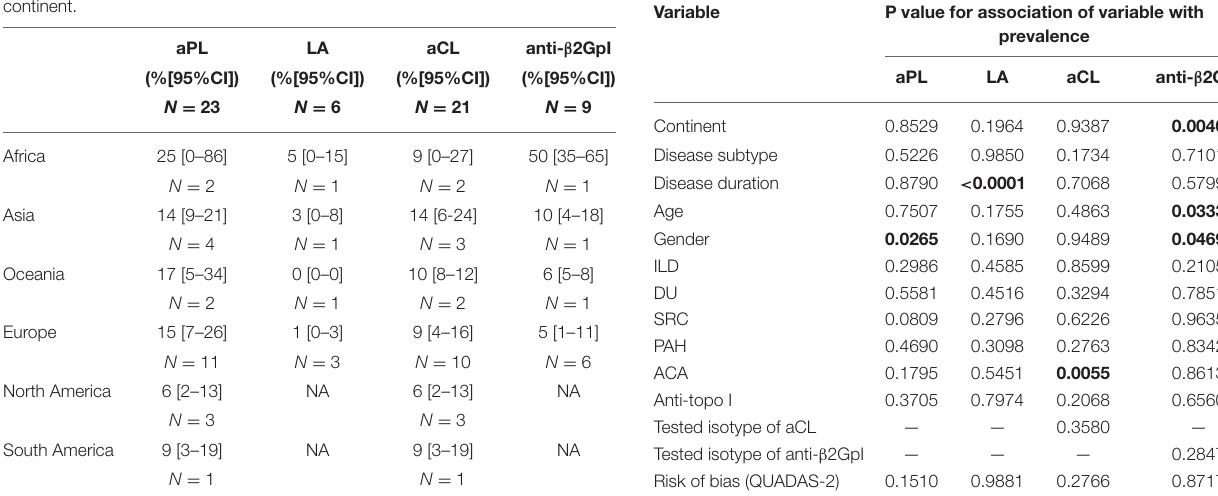
TABLE 5 | Prevalence of aPL, LA, aCL, and anti- β 2GpI in SSc, stratified by continent.